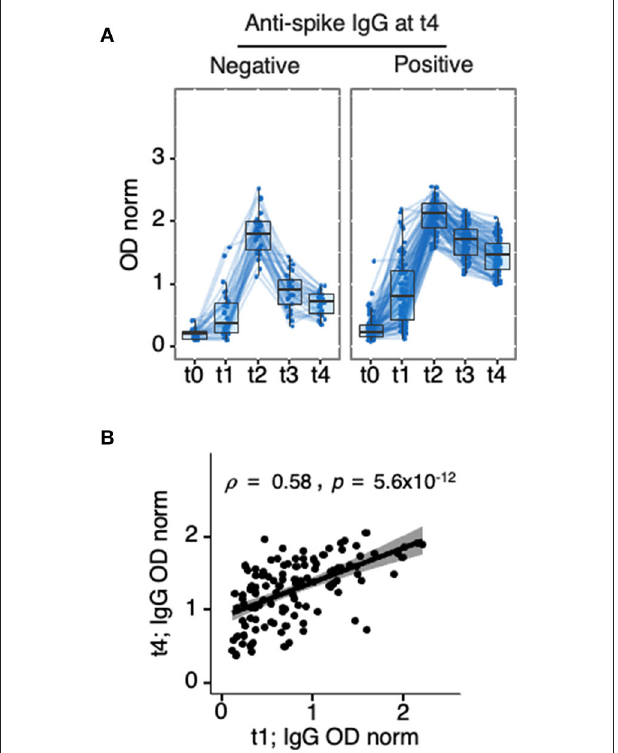
FIGURE 7 | Anti-spike IgG levels at t1 as a predictor of seroreversion. Longitudinal analysis of anti-spike IgG in HD patients who participated in the 5 collection time points (t0, t1, t2, t3, and t4). Ten non-responders (seronegative at t1 and t2) were excluded from the analysis, ( n = 116) (A) Partitioning of data presented in Figures 3 , 6 , showing HD patients classified as negative ( n = 39, left), or positive ( n = 87, right) at t4. (B) Spearman correlation coefficients ( ρ ) analysis of anti-spike IgG levels at t4 vs. t1 in same ( n = 126) patients, p- value inserted in the panel was obtained by Spearman’s rank-order non-parametric test. Detailed p- values presented in Supplementary Tables 11–13 . t0, sera collected on the day of first vaccine dose; t1, sera collected 21 days post-first vaccine dose; t2, sera collected 42 days post-first vaccine dose; t3, sera collected ∼ 140 days post-first vaccine dose; t4, sera collected 180 days post-first vaccine